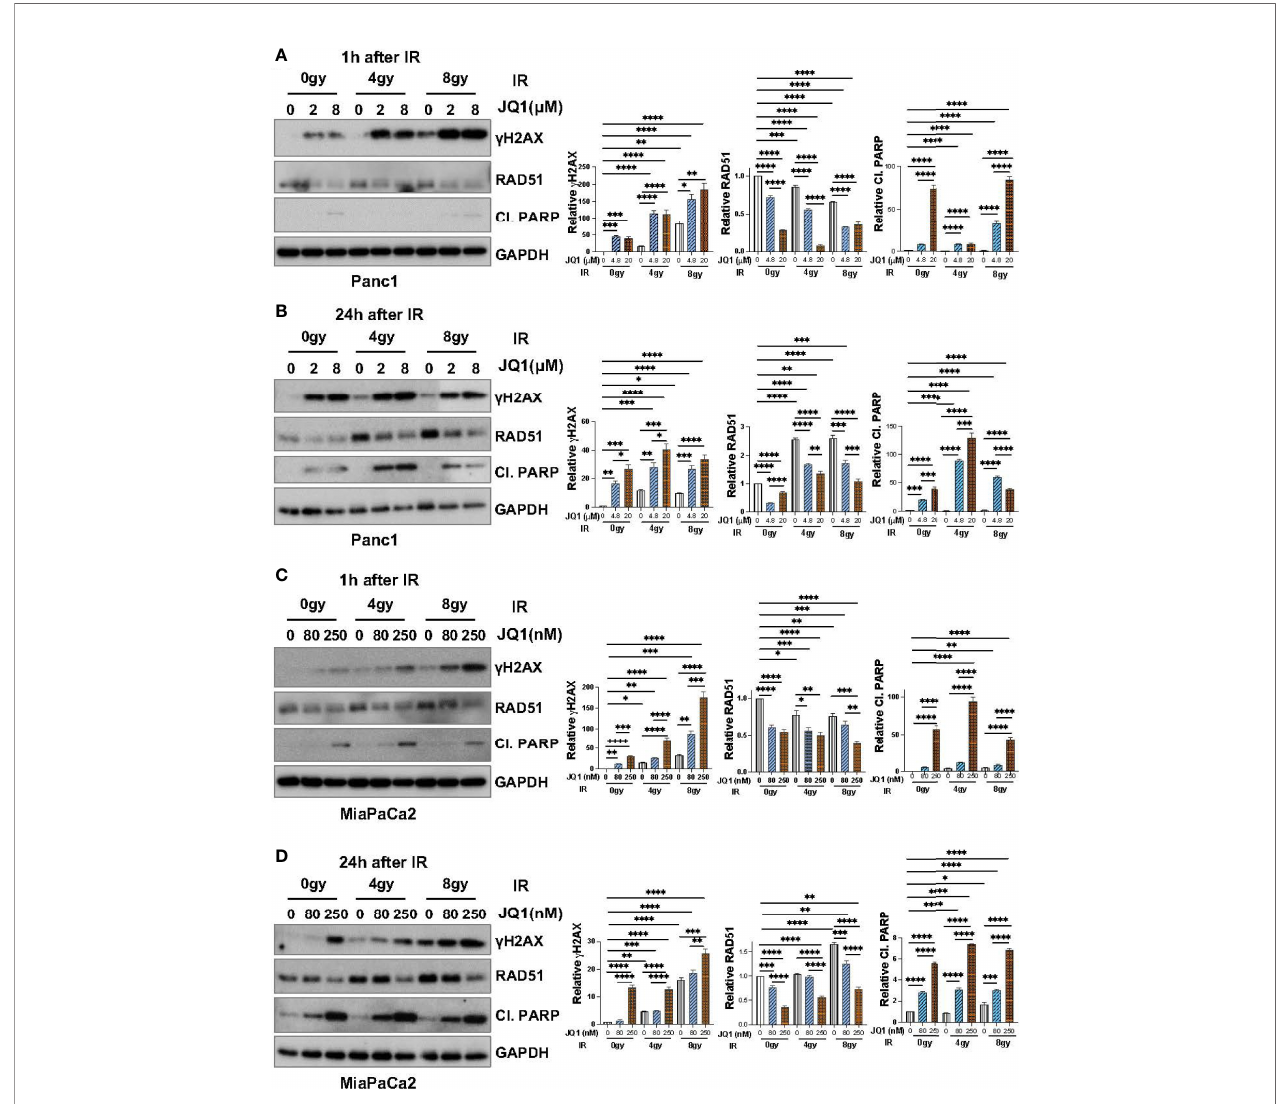
FIGURE 3 | Immunoblot data demonstrate that JQ1 + IR increases levels of the DNA damage marker g H2AX and decreases levels of the DNA repair protein RAD51 in Panc1 and MiaPaCa2 pancreatic cancer cells, and that the increase in g H2AX is concomitant with an increase in the apoptosis marker cleaved PARP (Cl. PARP). Images of representative immunoblots of Panc1 cells exposed to JQ1 ± IR, 1h after IR (A) or 24h after IR (B) , and of MiaPaCa2 cells 1h after IR (C) or 24h after IR (D) . Quantitation of g H2AX, RAD51 or Cl. PARP, was done using ImageJ software and analyzed using one-way ANOVA followed by Tukey multi comparison analysis. Quantitation is shown to the right of each immunoblot images as a bar graphs. *p < 005, **p < 0.01, ***p < 0.001, ****p <